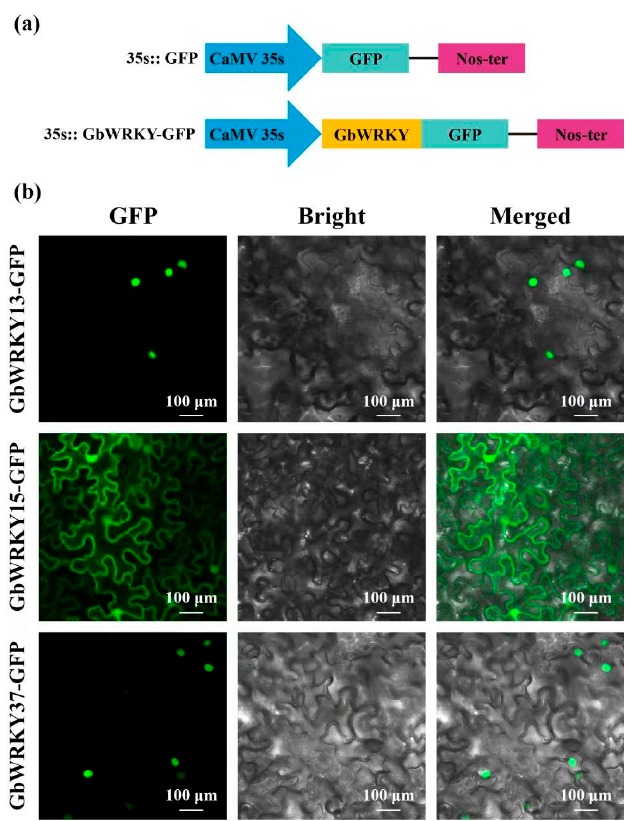
Figure 10. Subcellular localization of GbWRKY proteins. ( a ) Schematic illustration of the constructs. ( b ) Subcellular location of free GFP and GbWRKY-GFP protein in tobacco leaves.